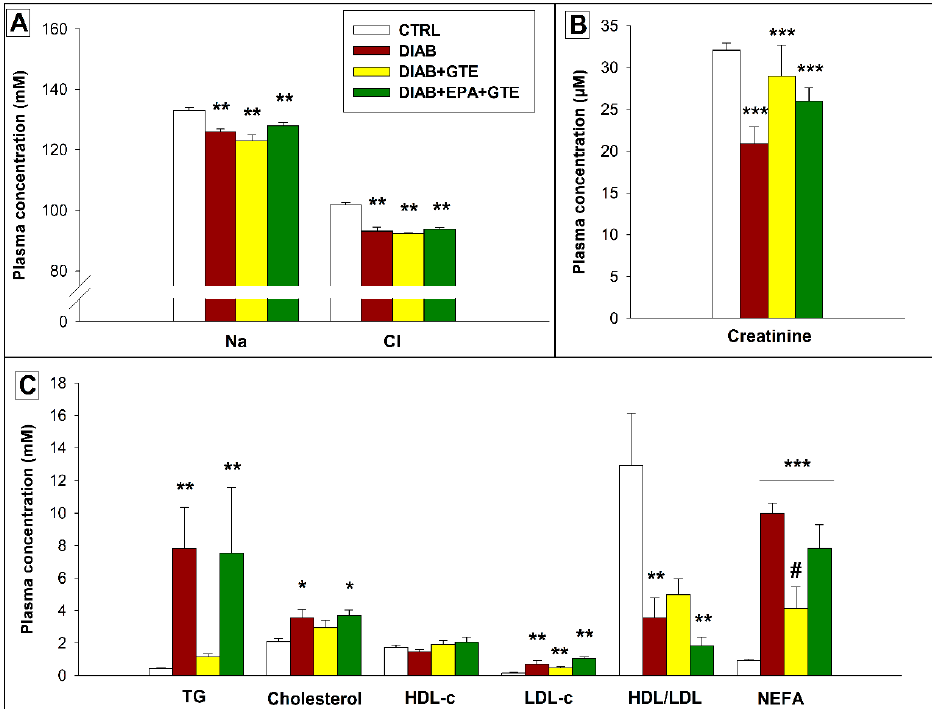
Figure 4. Plasma biochemical parameters. ( A ) Plasma ion diagram; ( B ) Plasma creatinine levels; and ( C ) Plasma lipid profiles. CTRL: Control group; DIAB: Diabetic rats; GTE: Green tea extract enrichment; and EPA: Eicosapentaenoic acid enrichment. Na: Sodium concentration; Cl: Chloride concentration; TG: Triglycerides; HDL-c: HDL-cholesterol; LDL-c: LDL-cholesterol; HDL / LDL: HDL-cholesterol to LDL-cholesterol ratio; and NEFA: Non-esterified fatty acids. * Different to the CTRL group. # Different to the DIAB group. One symbol (*): p < 0.05; two symbols (**): p < 0.01; and three symbols (***): p < 0.001. Table 4. Cardiac morphological and functional